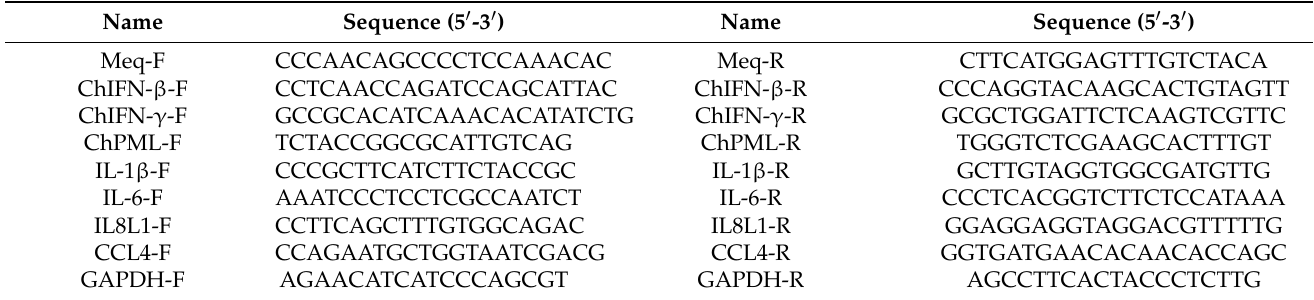
Table 1. Primers for qPCR in this